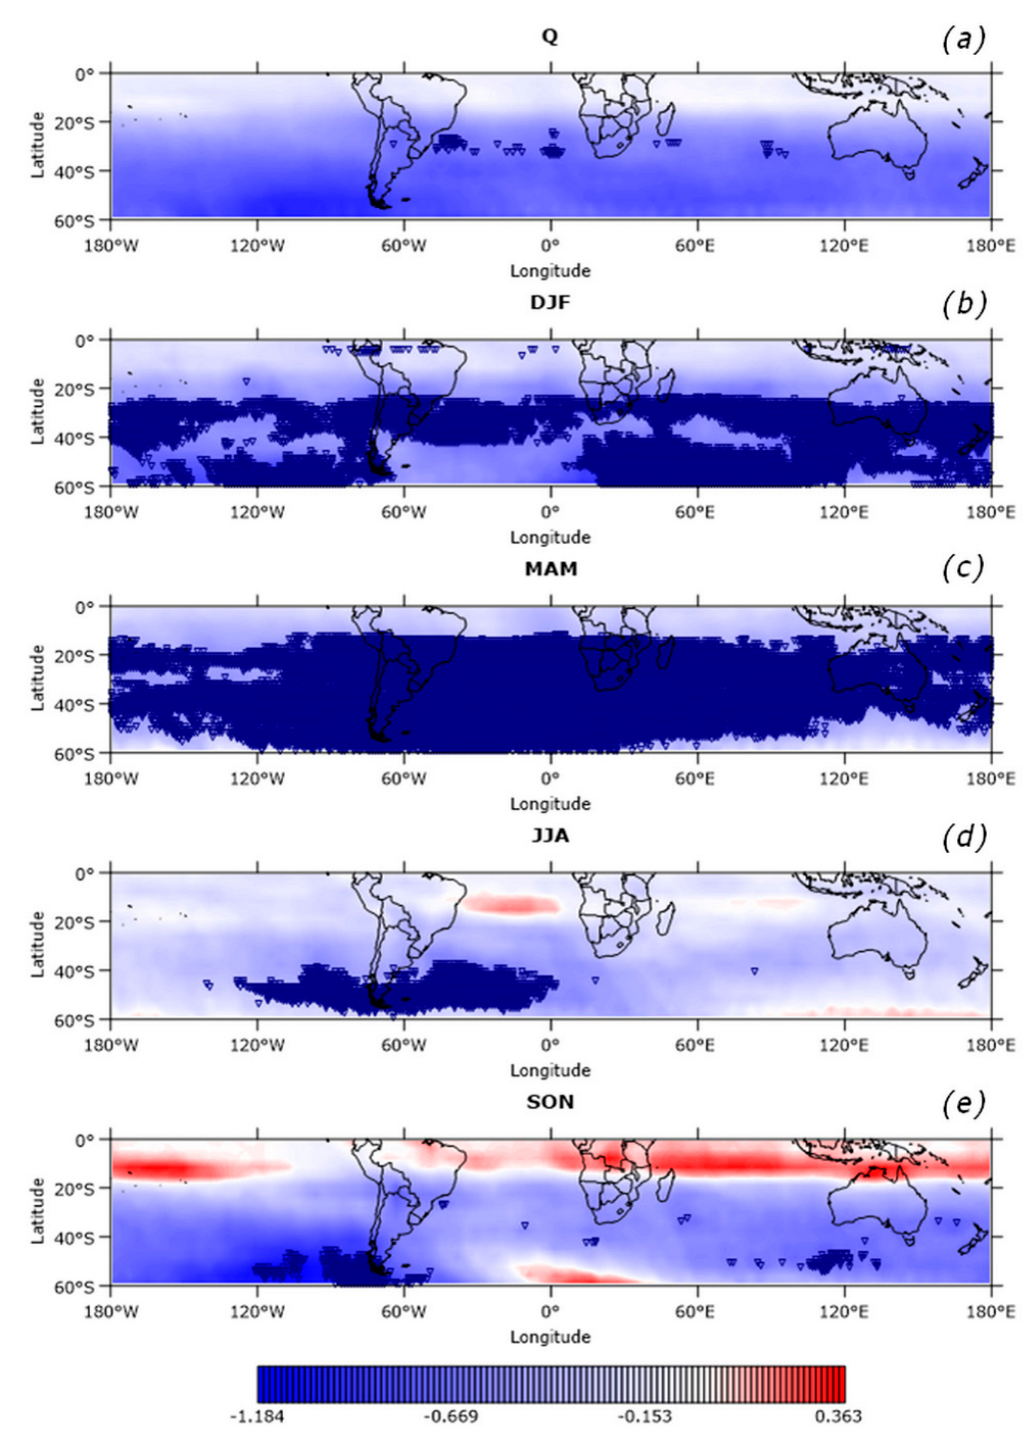
Figure 7. As in Figure 3 but for the seasonal concentrations of NO 2 in the stratosphere (Strat). Q, DJF, MAM, JJA and SON figures are shown in panels ( a – e ), respectively. The lack of previous research covering the topics dealt with in our paper does not permit direct comparison at a hemispheric scale. However, trends for tropospheric NO 2 concentrations were presented at major urban agglomerations in the SH [26]. According to Figure 6a the monotonic upward trends in Lima and SCL are in qualitative match with the results presented in [33] as they are in Jakarta and Sydney for a downward trend, whereas they do not match in Buenos Aires, Johannesburg, San Pablo and Rio de Janeiro, as the monotonic trends at these cities are not